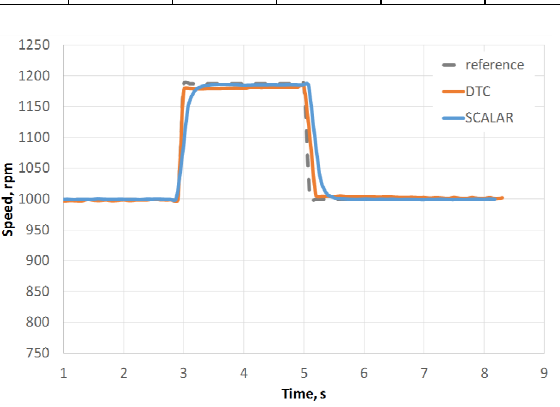
Fig. 7. Drive speed response profile around 1000 rpm at trapeze test cycle.